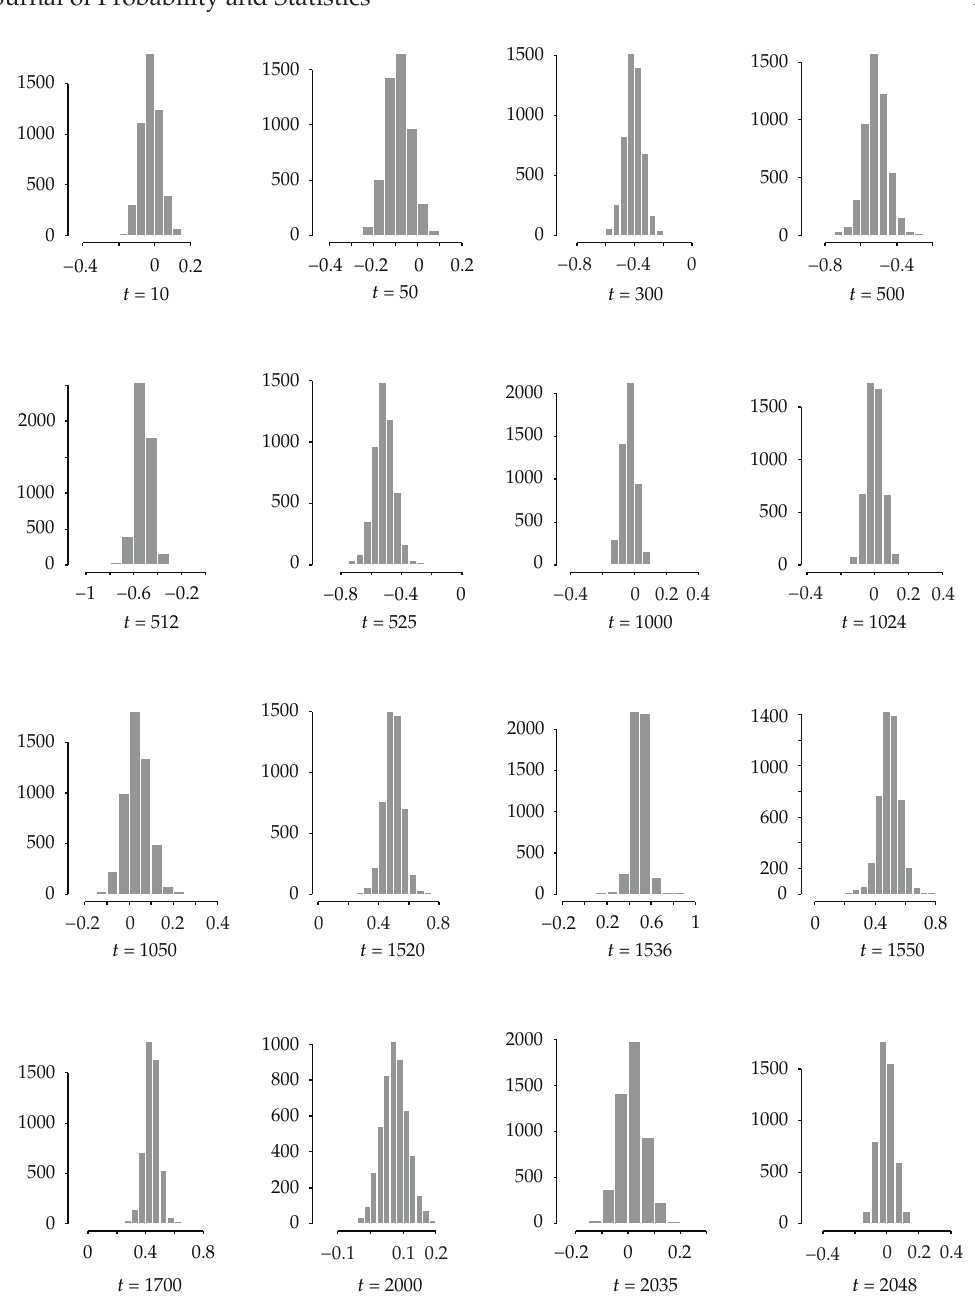
Figure 18: Example 5.1: Histograms of nonlinear estimate of δ 1 at some points of (cid:7) 0, 1 (cid:8) . We choose ω 0 (cid:5) u (cid:6) , δ 1 (cid:5) u (cid:6) , and δ 2 (cid:5) u (cid:6) as ω 0 (cid:5) u (cid:6) (cid:3) 0 . 9 cos (cid:5) 2 πu (cid:4) π (cid:6) , δ 1 (cid:5) u (cid:6) (cid:3) − 0 . 5 sin (cid:5) 2 πu (cid:6) , and δ 2 (cid:5) u (cid:6) (cid:3) − 0 . 4 cos (cid:5) 2 πu (cid:4) π/ 4 (cid:6)